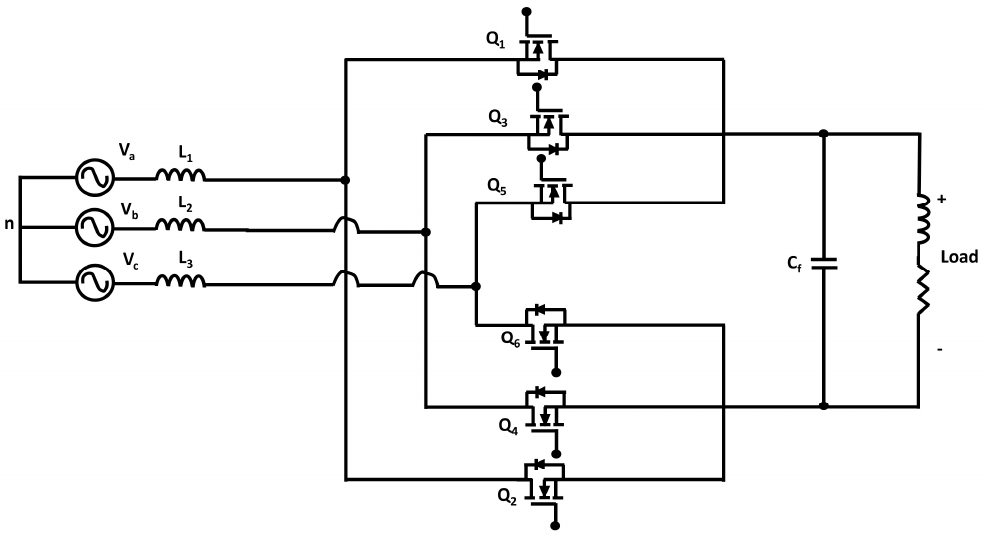
Figure 7. Three-phase bridgeless boost rectifier.